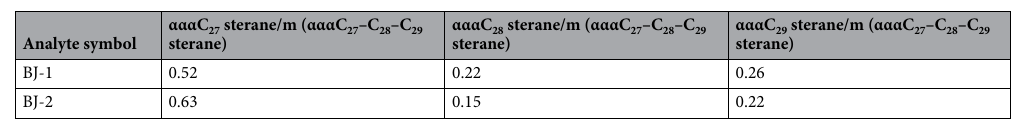
Table 4. Relative proportions of C 27 sterane, C 28 sterane, and C 29 sterane.